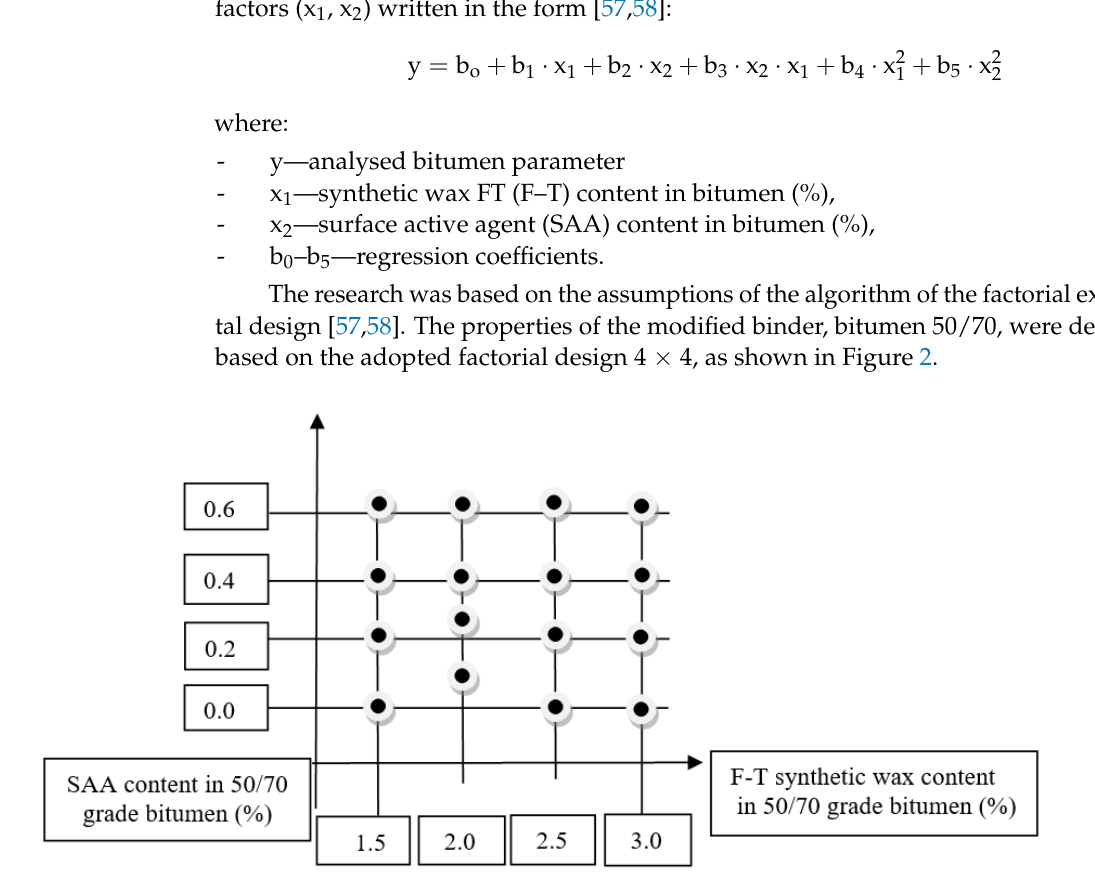
Figure 2. Experimental design.